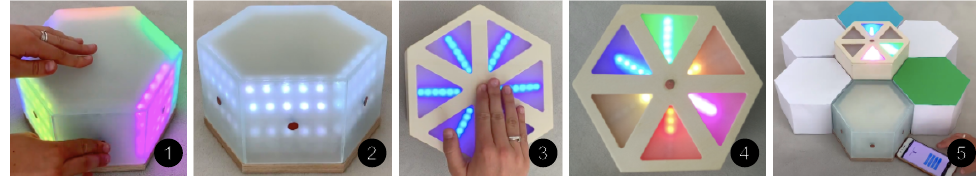
Figure 4. Group Hexagon technical prototype ( 1 . touch side button to choose an answer with individual- hexagon ( IH ); 2 . show timer with light progress bar in the IH ; 3 . touch the top button to seek help with the group-hexagon ( GH ); 4 . show answer distribution in the GH ; 5 . app mode to interact and control IH